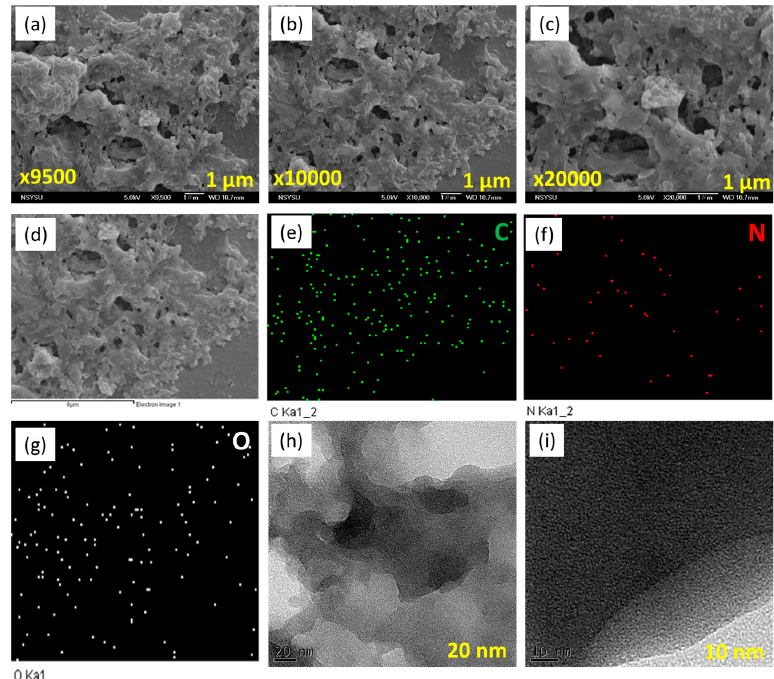
Figure 3. SEM ( a – c ), EDS-SEM ( d – g ), and TEM ( h , i ) images of Py-PDT